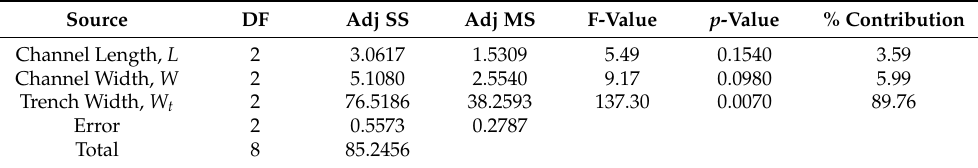
Table 10. ANOVA results for V .